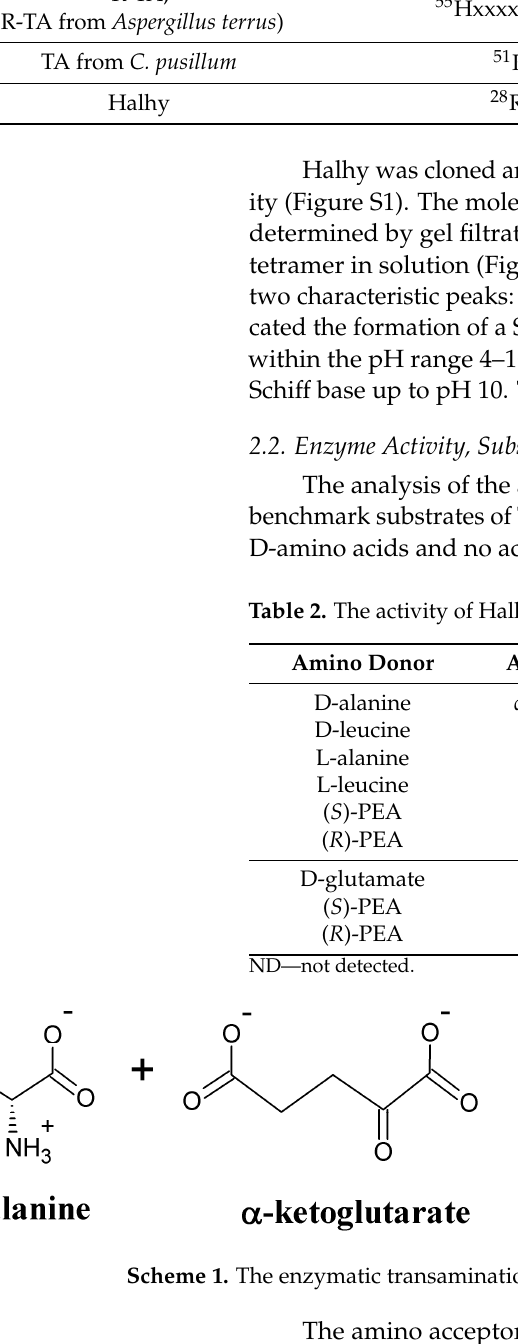
Table 1. The specificity-determining sequence motifs of the canonical DAATs, BCATs, R-TAs, TA with an expanded substrate specificity from C. pusillum and TA from H. hydrossis (Halhy), according to Höhne et al.